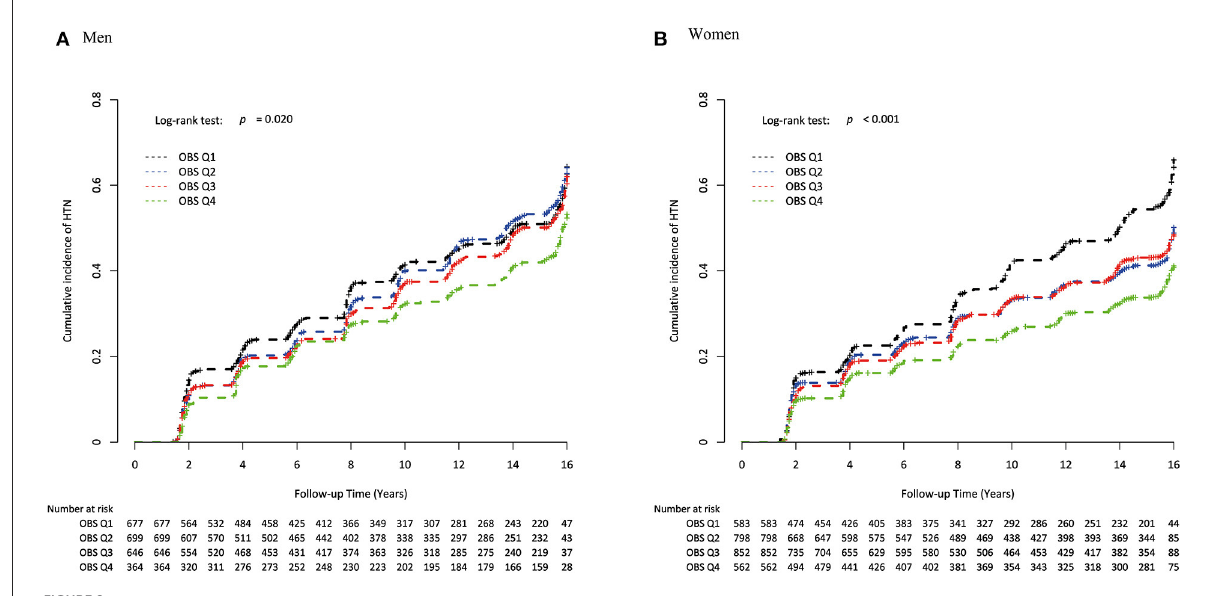
FIGURE2 Inverse Kaplan-Meier plot of incident HTN by sex-specific OBS quartile in (A) men and (B) women. HTN, hypertension; OBS, oxidative balance score.